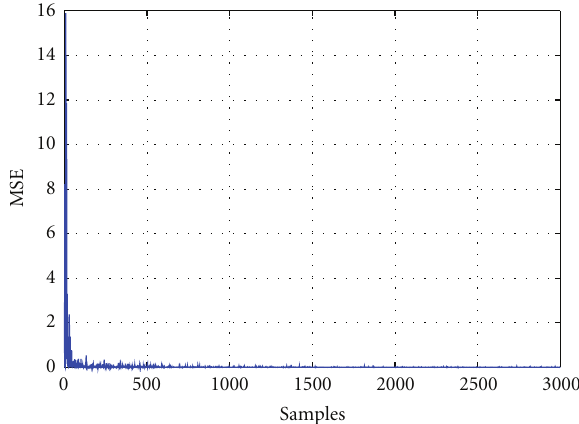
Figure 5: Mean square plot of LeNN based noise prediction model for 3000